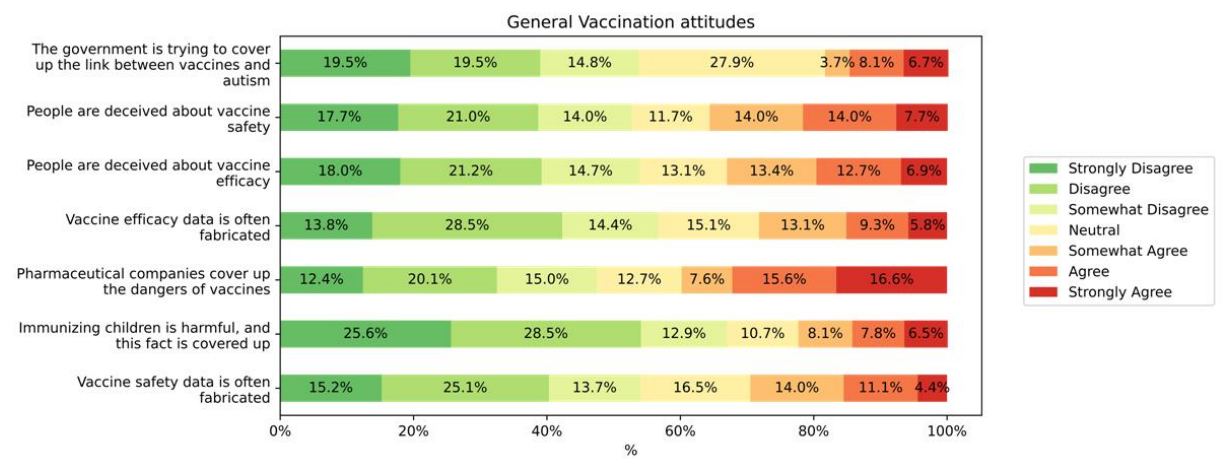
Figure 3. Cause of the rejection of HPV vaccines among the Algerian students.